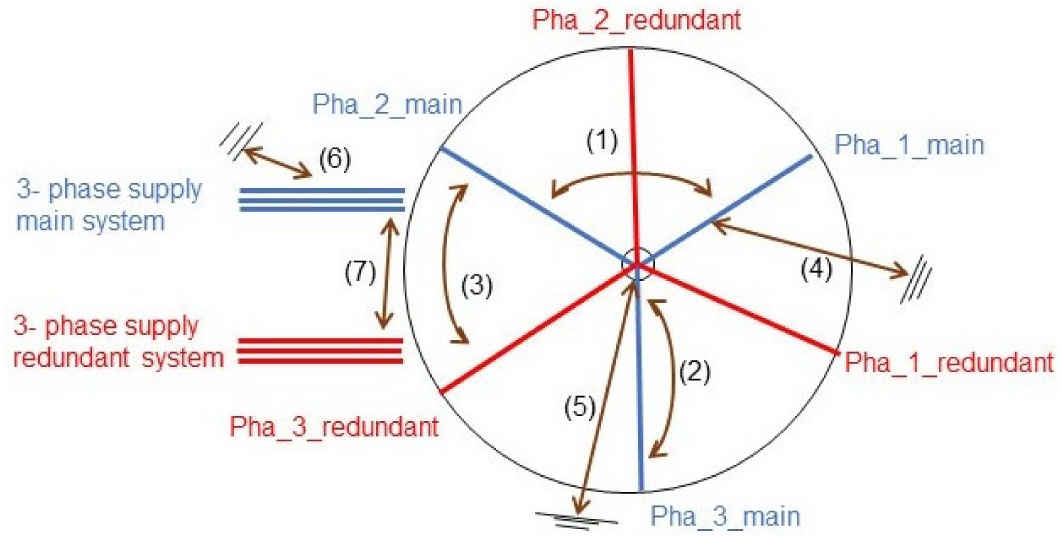
Figure 5. Failure classification of short circuit scenarios for motors with redundant winding